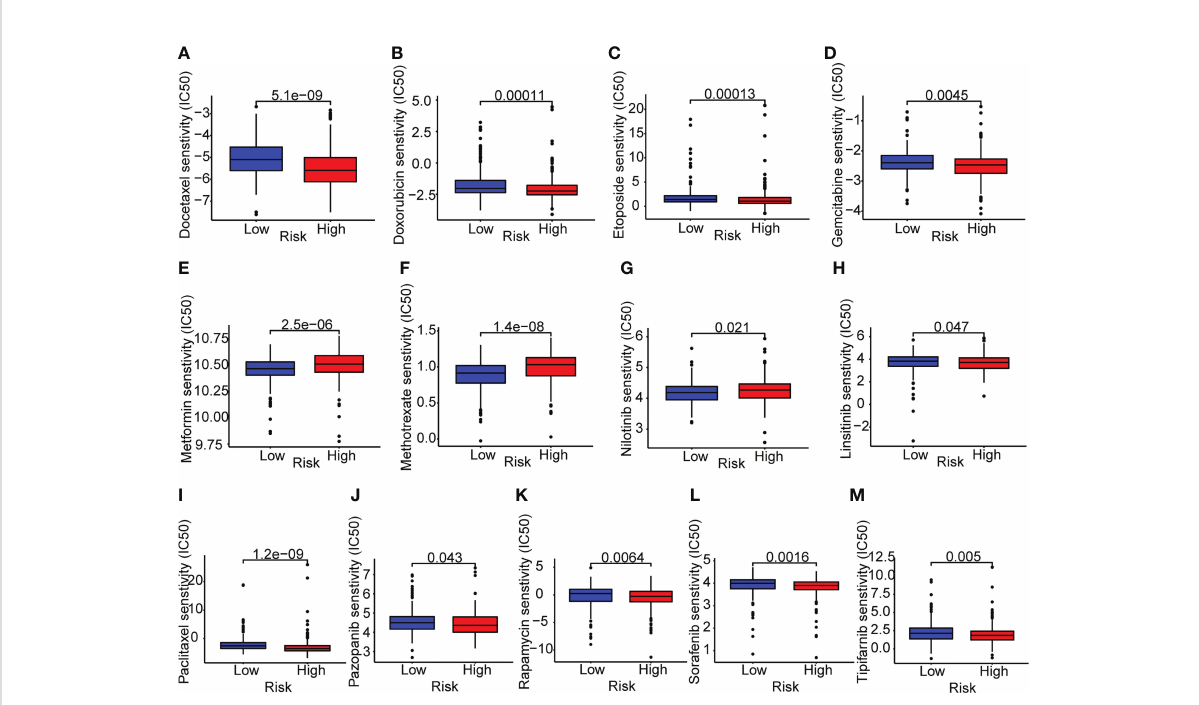
FIGURE 9 Drug sensitivity analyses in lung adenocarcinoma patients. (A – M) Boxplots of the two risk groups showed the mean IC50 differences of 13 representative drugs (docetaxel, doxorubicin, etoposide, gemcitabine, metformin, methotrexate, nilotinib, linsitinib, paclitaxel, pazopanib, rapamycin, sorafenib,